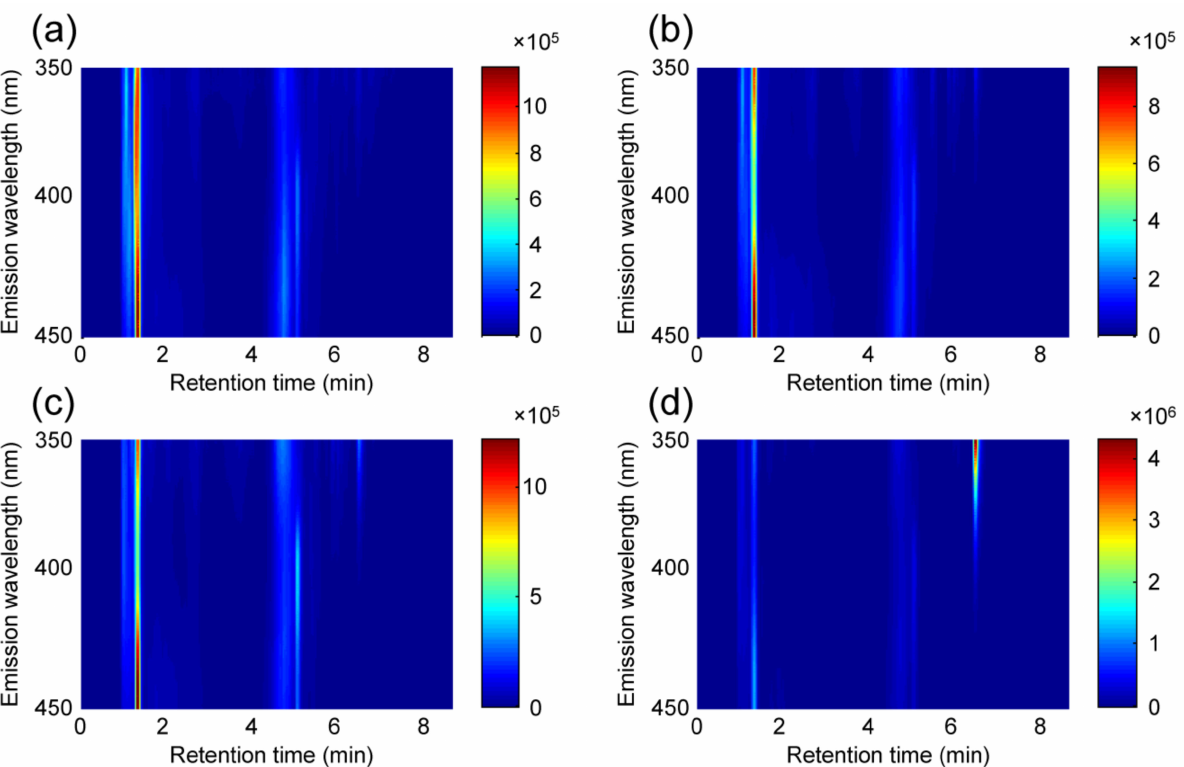
Figure 1. Counter maps of second-order HPLC-FLD fingerprints of ( a ) Sichuan EJT, ( b ) Guizhou EJT, ( c ) Guizhou BL, and ( d ) Henan BL after subtracting the solvent